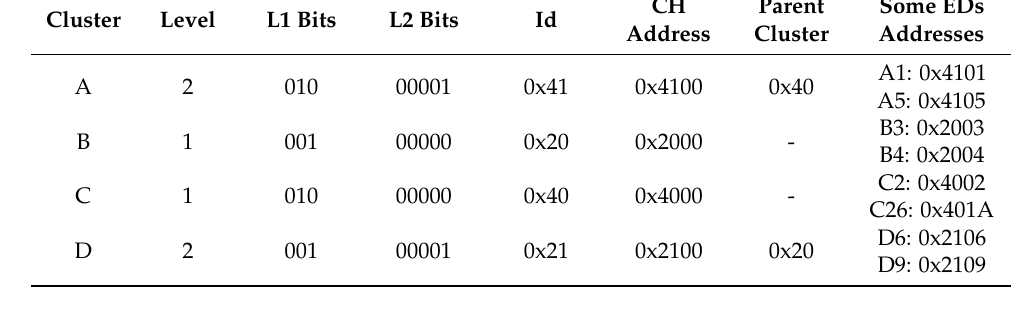
Table 8. Energy consumption on NB ‐ IoT link.